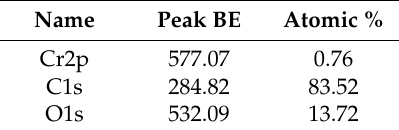
Figure 8. XPS spectra of the TFS surface.